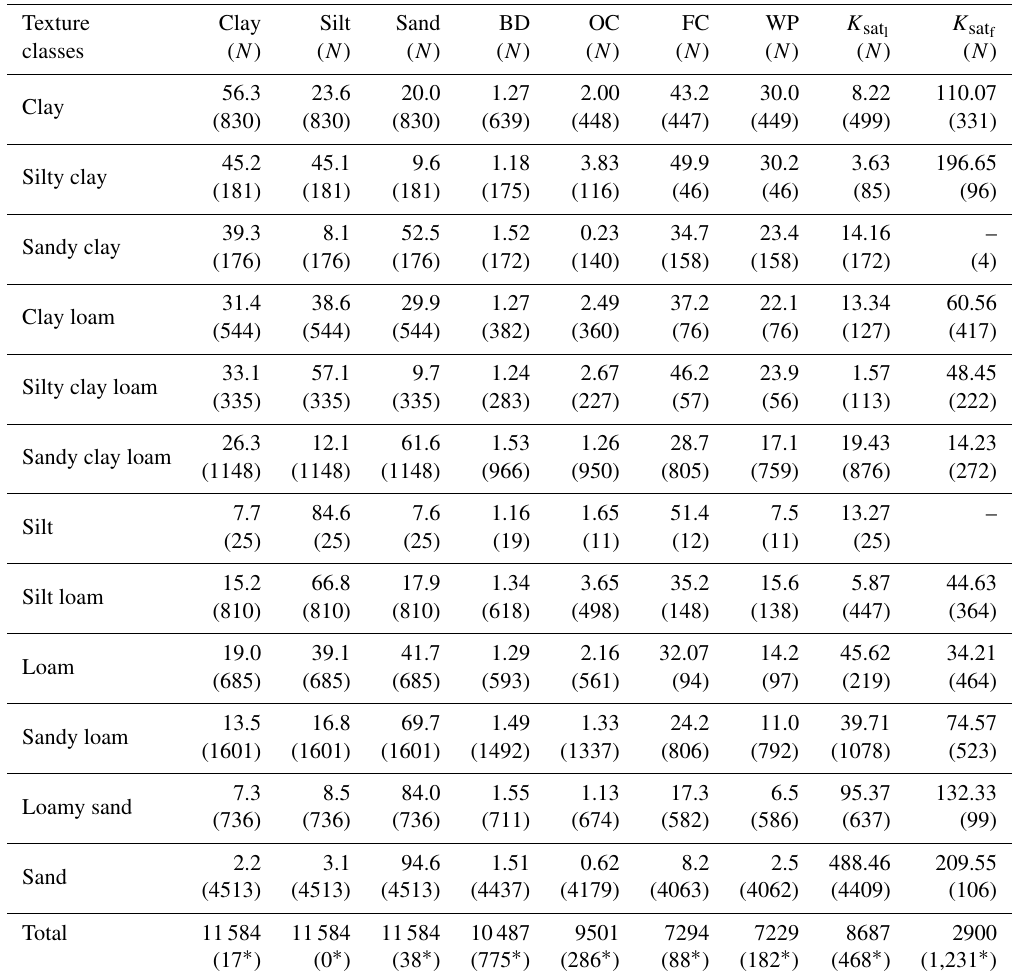
Table 5. Mean values of soil hydrophysical properties for each soil textural class. The number of samples ( N ) is given in parentheses under each soil variable for each soil texture classes. N values marked with ∗ correspond to undefined soil texture class. BD: bulk density (gcm − 3 ); OC: soil organic carbon content (%); FC: moisture content at field capacity (vol%); WP: moisture content at wilting point (vol%); K sat K sat are laboratory and field K sat (cmd − 1 ), respectively. For K sat , the geometric mean is reported (due to the sensitivity to a few extreme f values for the arithmetic mean). For all other properties the arithmetic mean is